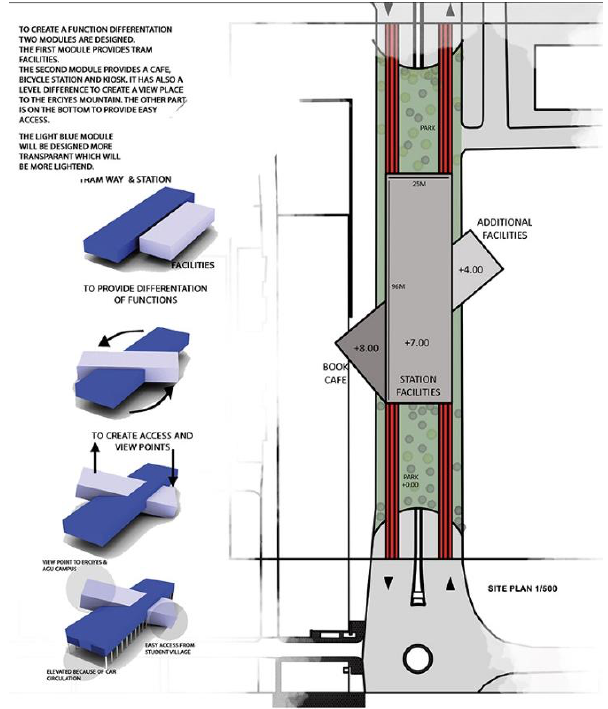
Figure 11 From finding process and the site plan of a design suggestion (Hilal